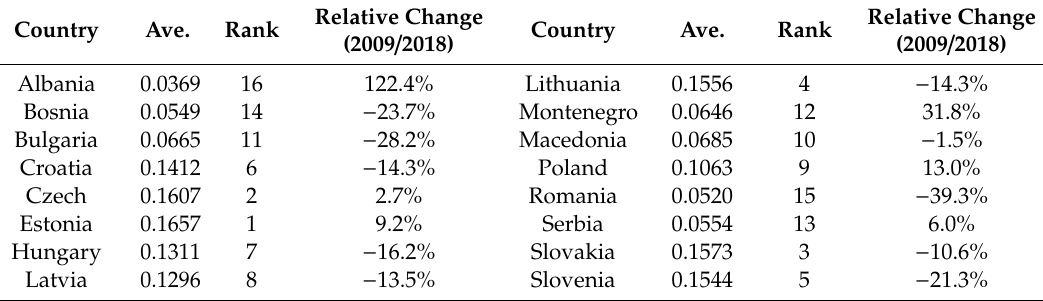
Table 9. Average evaluation results of technical climate in CEE